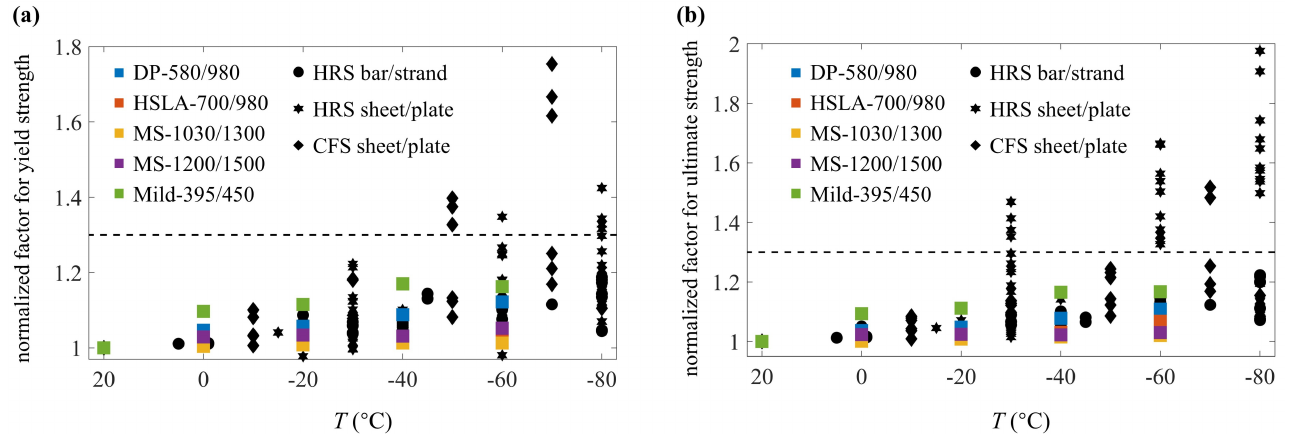
Figure 10. Normalized factors of ( a ) yield strength and ( b ) ultimate strength for AHSS, HSLA- 700/980, Mild-395/450, and data from published experiments. The dashed line represents an increase of 30% compared with